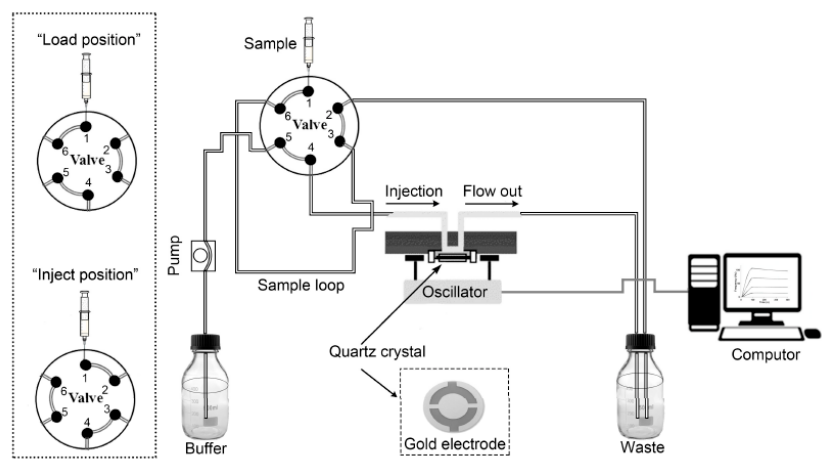
Figure 1. Continuous flow system of the Attana QCM biosensor [15].